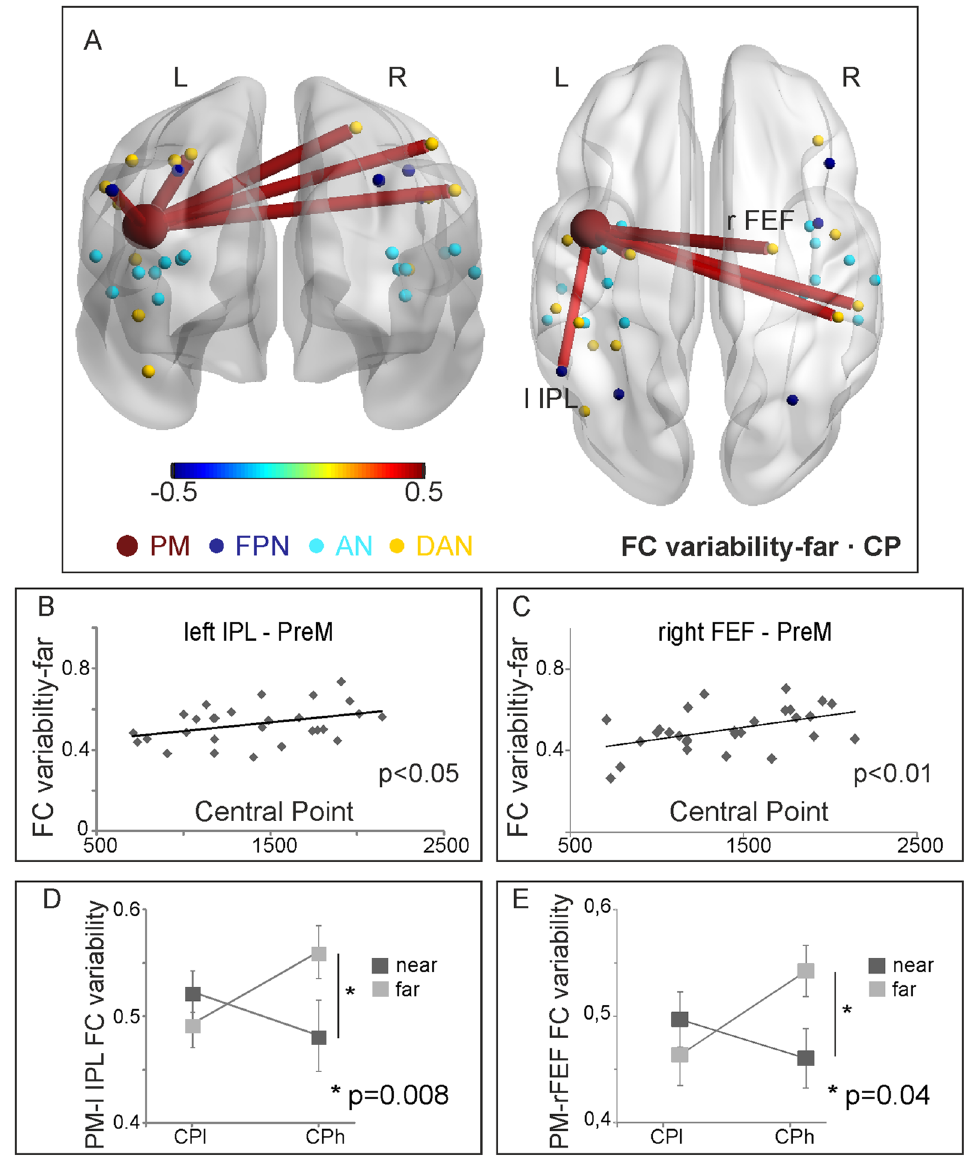
Figure 5. ( A – E ) Results of FC variability analysis. Significant correlation coefficient between FC variability and PPS extension (CP) during the far space condition is displayed on the standard brain in posterior and dorsal views ( A ) and using a scatter plot of FC variability as a function of CP ( B , C ). The variability of connectivity between PM and left IPL ( D ) and between PM and right FEF ( E ) is shown for two groups of subjects with different extension of PPS (participants with wide and narrow PPS, CPl and CPh respectively) in the near and far conditions. Significant interaction of group (CPh, CPl) x space (near, far), and the results of post-hoc test are shown in the corresponding